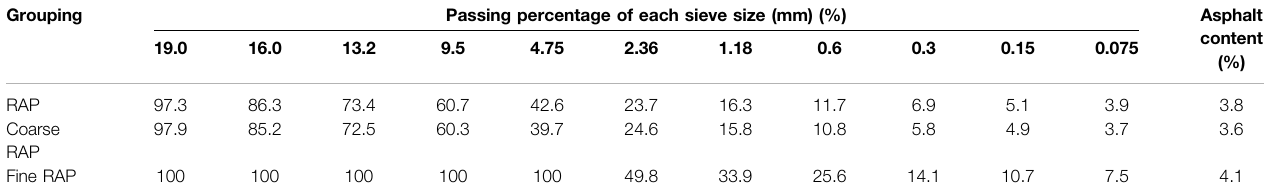
TABLE 1 | Results of recovered AC-20 common asphalt mix components. Grouping Passing percentage of each sieve size (mm) (%) Asphalt